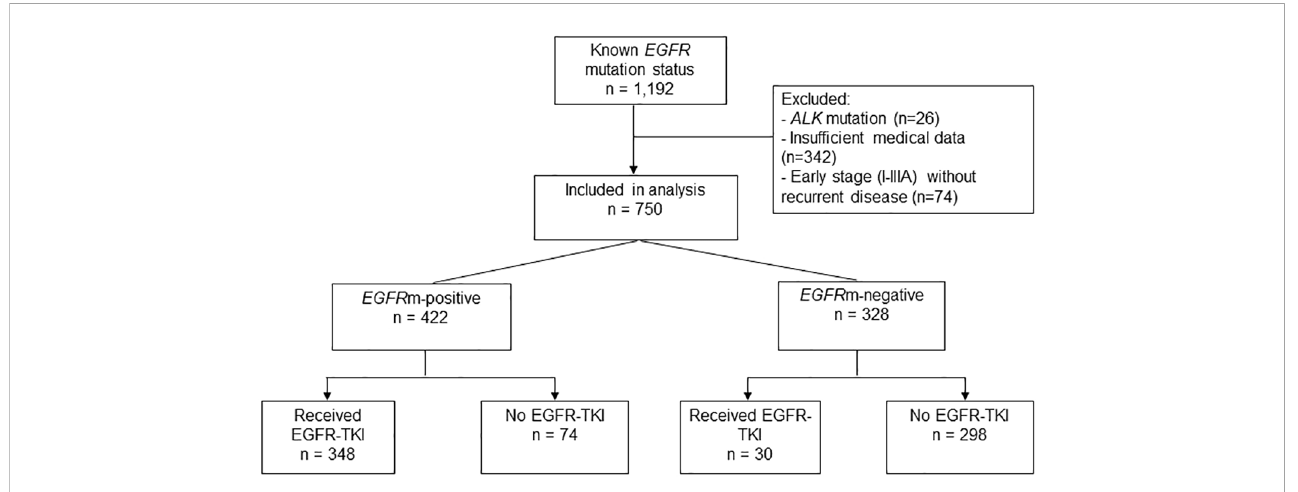
FIGURE 1 Flowchart of patient selection in the